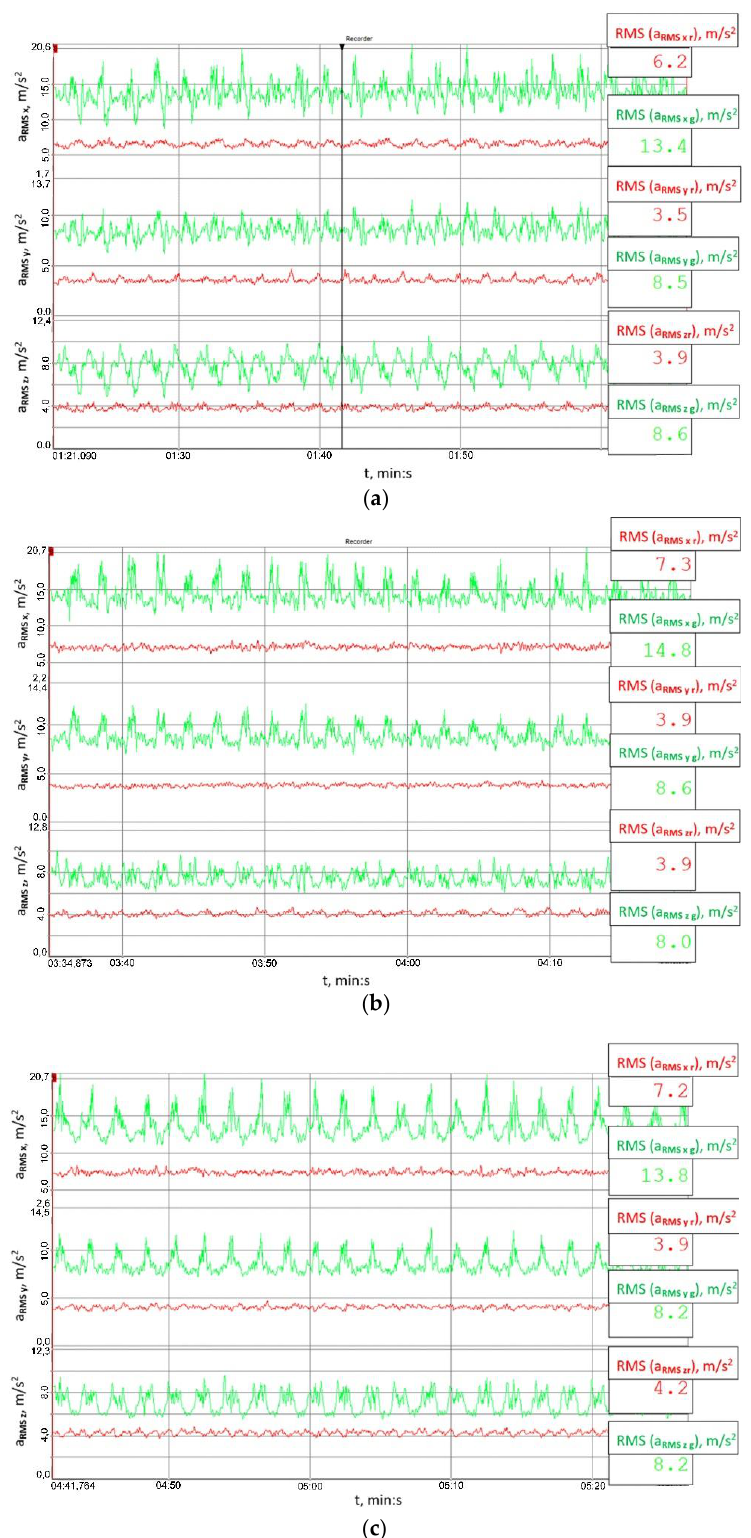
Figure 14. Behaviour of the RMS values of the signals recorded at the output shaft housing in the multi-stage reduction gear (point 14519) established within a time window moved along the time axis: ( a ) 41.8 ± 27.9 Nm, ( b ) 79.2 ± 55 Nm, ( c ) 114.8 ± 75.9 Nm; red colour marks the results obtained for the flexible operation mode of the clutch; green colour corresponds to the locked operation mode.